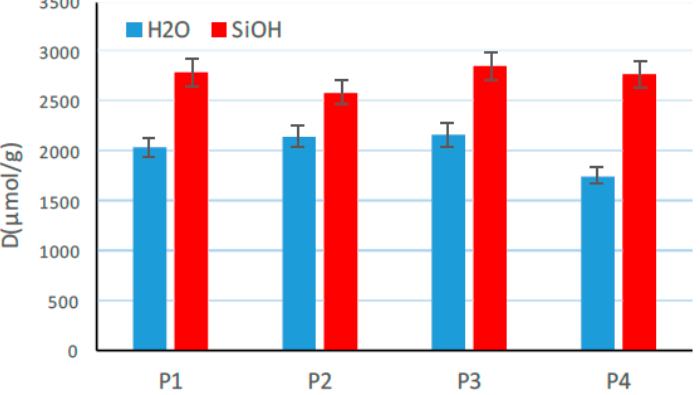
Figure 11. Water (blue) and silanol (red) content (“D” in µmoL/g) of one type of silica in four different forms: P1 (untreated reference), P2 (dried at 105 °C for 2 h), P3 (compressed with 125 MPa) and P4 (dried and compressed with 125 MPa) [34].